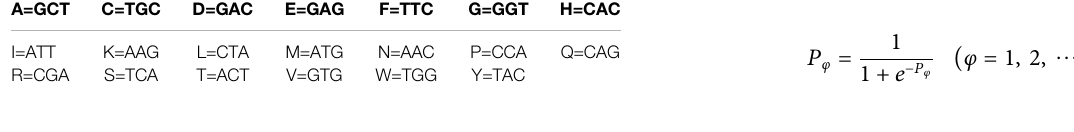
TABLE 2 | Reverse encoding for the amino acids used in this study.